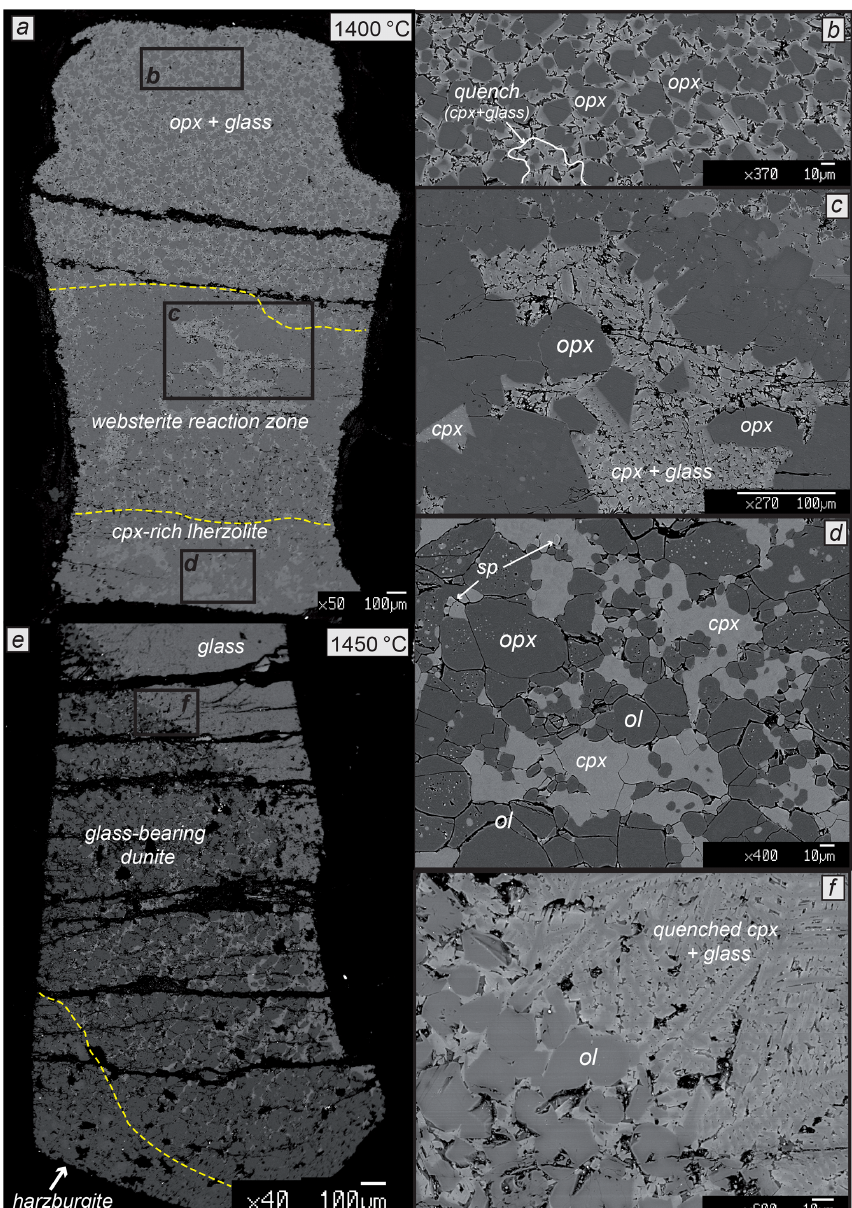
Figure 5. Back-scattered electron (BSE) images of the experimental charges and representative textures after reaction runs at 2GPa and 1400 ◦ C and 1450 ◦ C. (a) Reaction run at 1400 ◦ C produced (b) a molten pyroxenite layer formed by residual orthopyroxene (opx) and interstitial matrix of glass and quenched clinopyroxene; (c) a websterite reaction zone made of orthopyroxene, clinopyroxene, minor olivine and interstitial glass; and (d) lherzolite layer showing slightly higher clinopyroxene modal abundances. (e) Reaction experiment at 1450 ◦ C is characterized by a large portion of glass plus quenched minerals at the top of the capsule at the contact with glass-bearing dunite (f) that covers the central portion of the charge and is limited by glass-free harzburgite at the